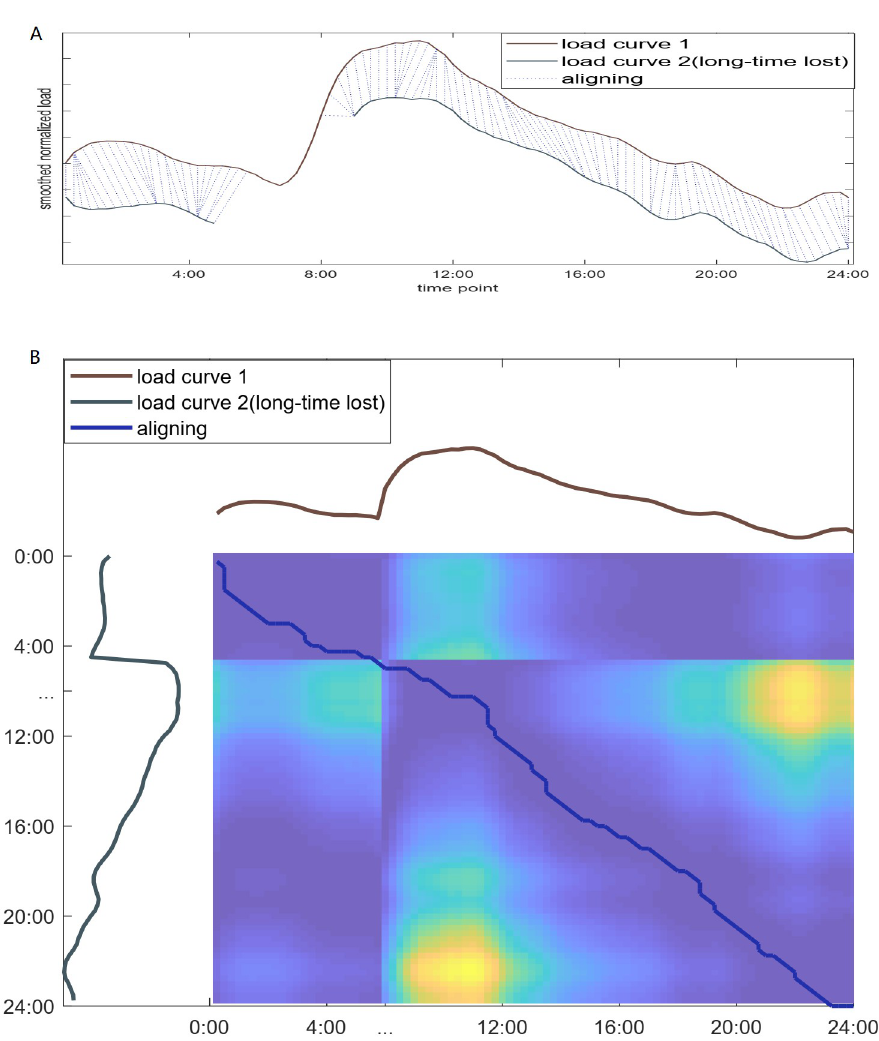
Fig 5. Long period missing values. (A) shows the long period missing values in load curve; (B) shows the heat map of dynamic warping and the new align